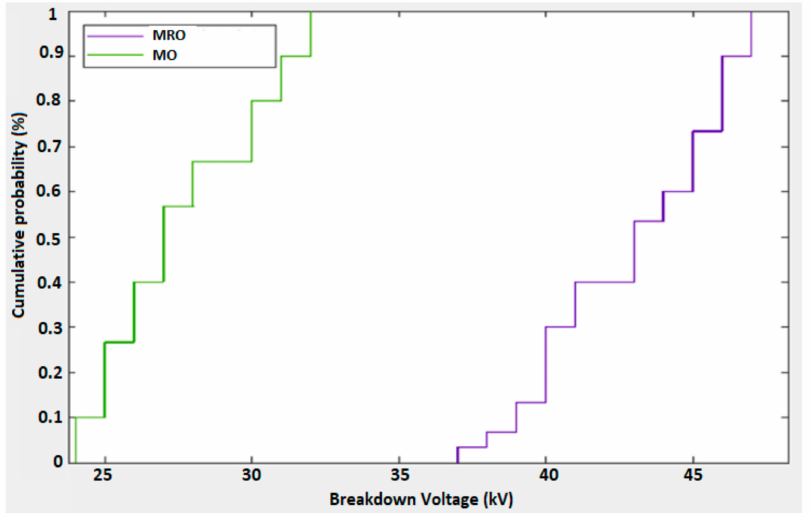
Figure 2. Cumulative probability of breakdown instances of MRO showing wider range and MO showing linear